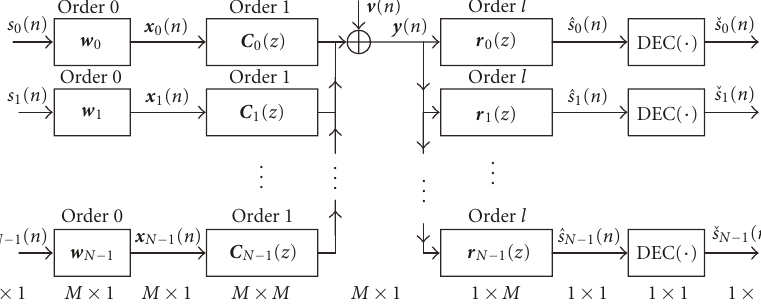
Figure 2: Block model of the N users DS-CDMA